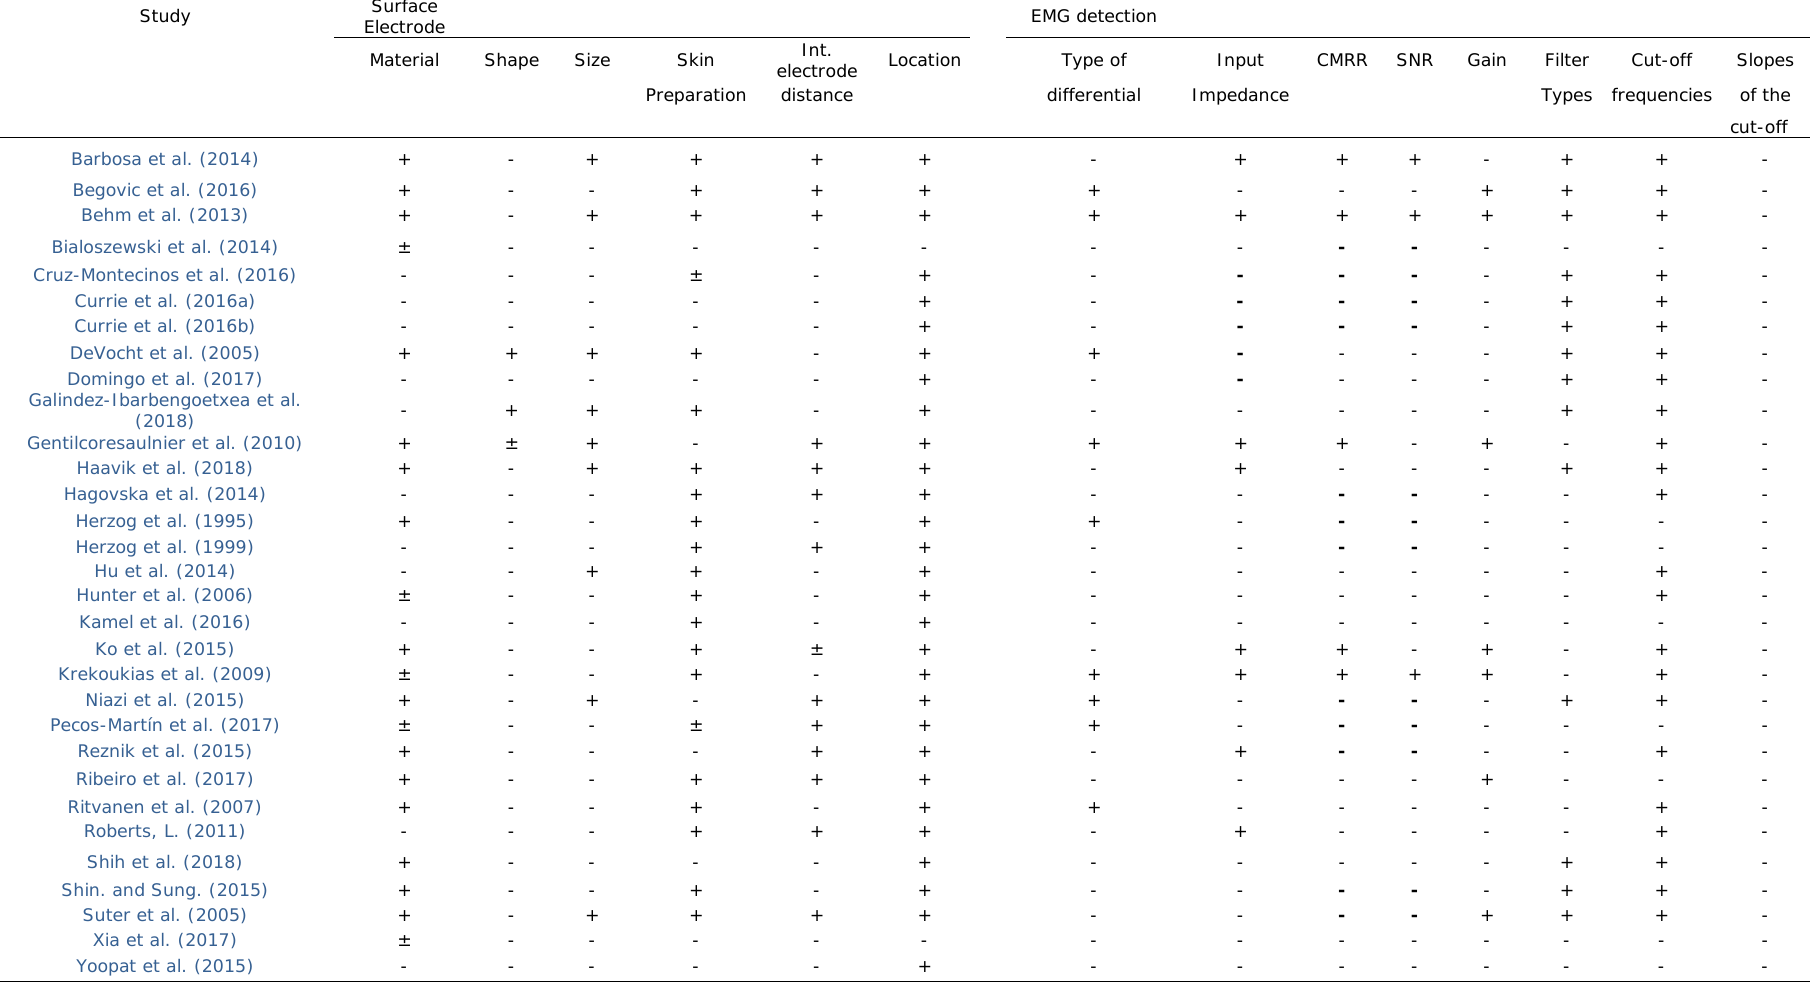
Table 5. Check-list for the ISEK standards for reporting EMG data. Format adapted from Januario et al.,